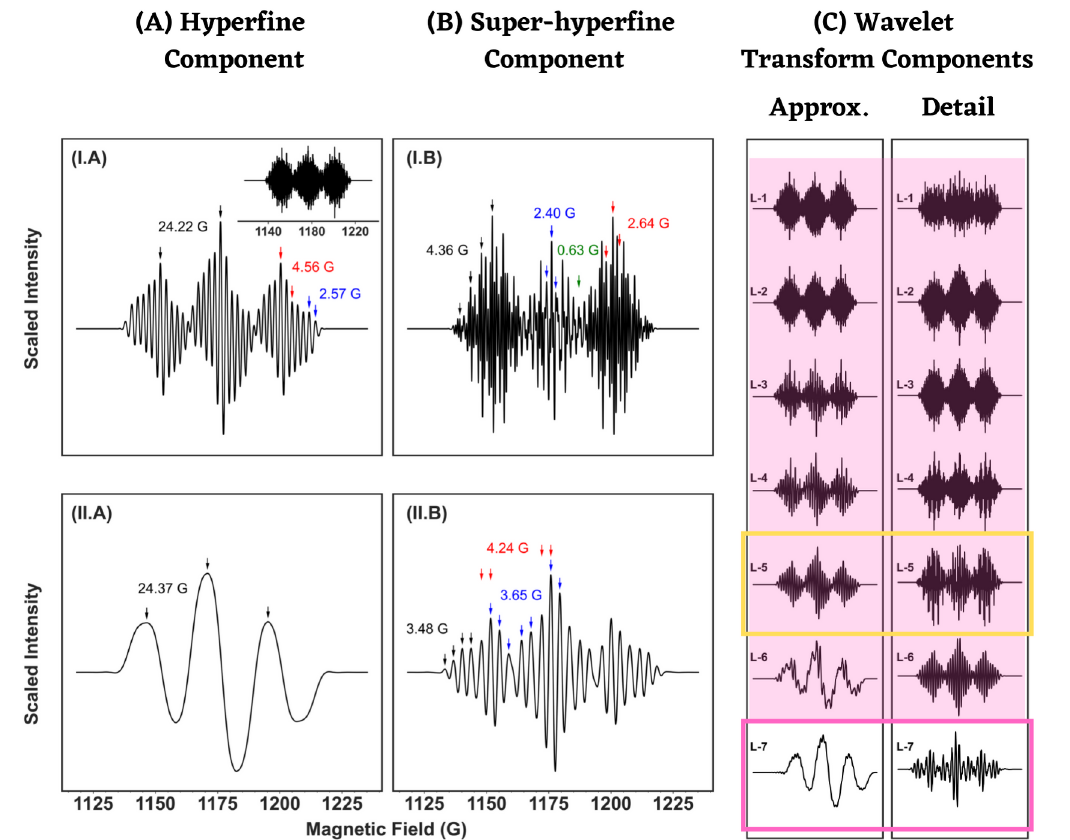
Figure 3. Separation of hyperfine ( A ) and super-hyperfine ( B ) components of an ESR spectrum of R-II at S-band. Figure ( I.A ) inset shows the simulated ESR spectra. Wavelet transform analysis from level-1 to level-7 is shown ( C ). Complete separation of hyperfine and super-hyperfine components occurred at level-7 (magenta box) after removing the detail component in each level of the wavelet transform application (magenta background). Much of the super-hyperfine coupling information was lost by level-7, while partial separation at level-5 (yellow box) was appropriate in resolving the super-hyperfine components. Resultant spectral components at both level-5 (I) and level-7 (II) are shown. The colored pair of arrows and text in ( A , B ) indicate resolved hyperfine and/or super-hyperfine